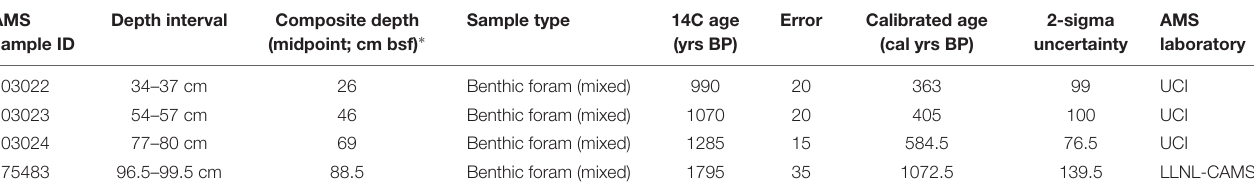
TABLE 1 | Radiocarbon samples for